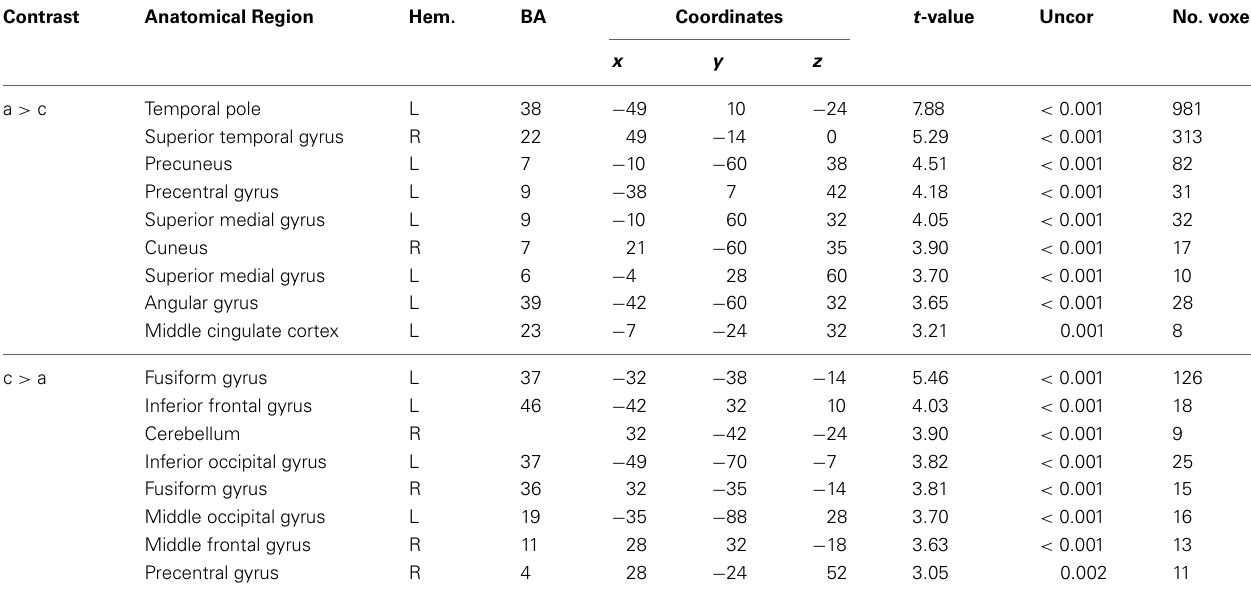
Table 5 | Main effect for abstractness and concreteness.